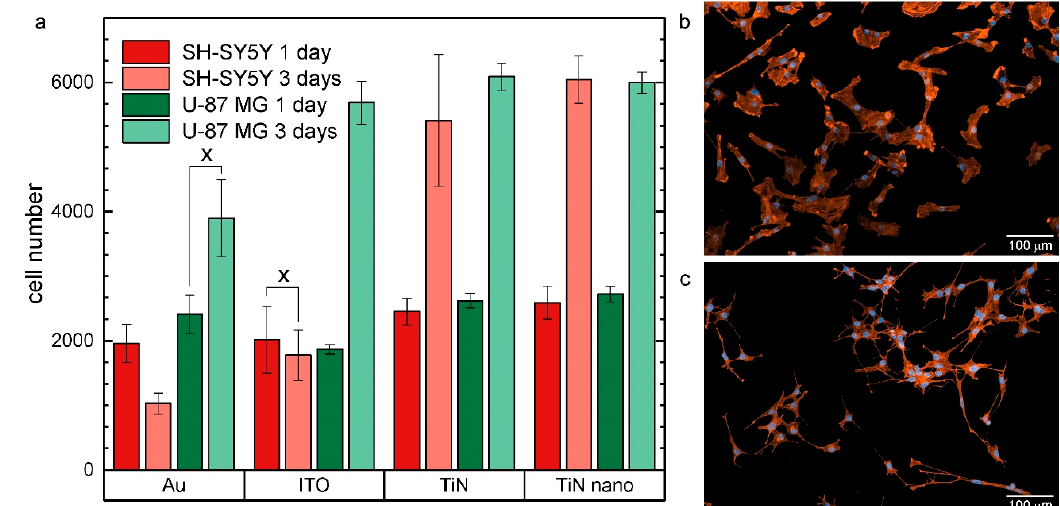
Figure 2. ( a ) Average number of SH-SY5Y and U-87 MG cells grown on different electrode materials (Au, ITO, TiN, nanocolumnar TiN) after one and three days in culture. Values marked with x are not statistically significant ( p > 0.05); ( b ) fluorescent image of U-87 MG cells cultured on TiN nanocolumnar surfaces for 1 day. Cell nuclei are blue and actin fibers are colored orange. The scale bar represents a length of 100 µm; ( c ) fluorescent image of SH-SY5Y cells grown on a TiN nanocolumnar substrate for 1 day plus additional 72 h incubation with culture medium supplemented with staurosporine to induce cell differentiation. Colors and scale bar as in ( b ).